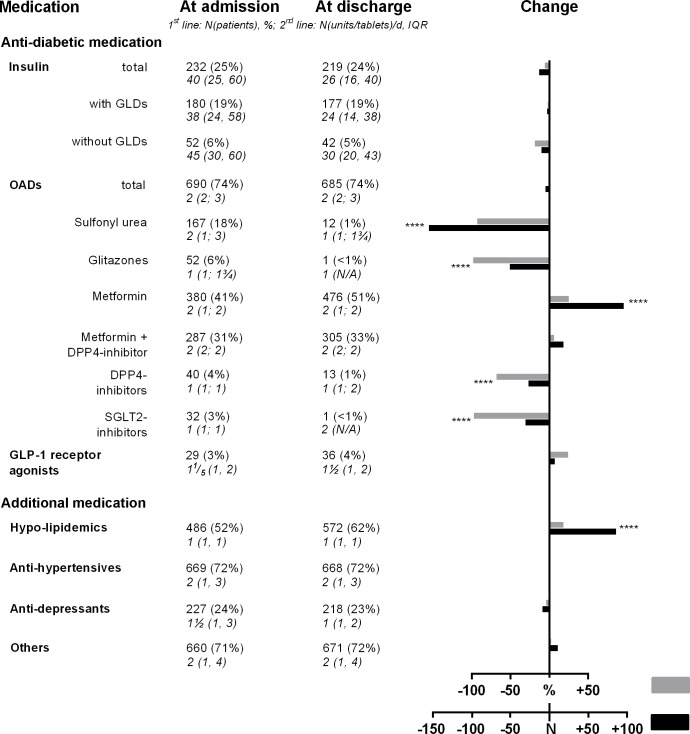
Medication (antidiabetic, hypo-lipidemic, antihypertensive, antidepressant, others) at admission and discharge (grey: relative change from baseline, black: absolute change).p-Values are derived by McNemar tests assessing changes in the number of patients under treatment for each entity. GLDs, glucose-lowering drugs other than insulin; OADs, oral antidiabetic drugs; ****, p<0.0001.